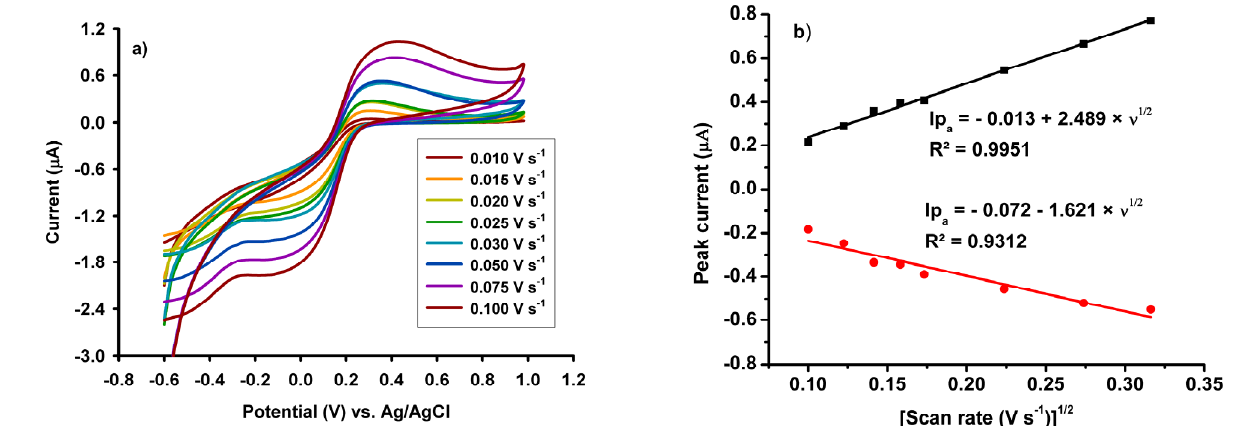
Figure 2. ( a ) Cyclic voltammograms in a solution of 5.0 × 10 − 3 mol L − 1 K 3 [Fe(CN) 6 ] (0.1 mol L − 1 KCl) at different scan rates from 0.010 to 0.100 V s − 1 using the TPP/AuNPs-S-Gr sensor (working conditions: potential range from − 0.6 to 1.0 V; step potential 0.025 V). ( b ) Dependence of the peak current on the square root of the scan rate, using the TPP/AuNPs-S-Gr sensor.